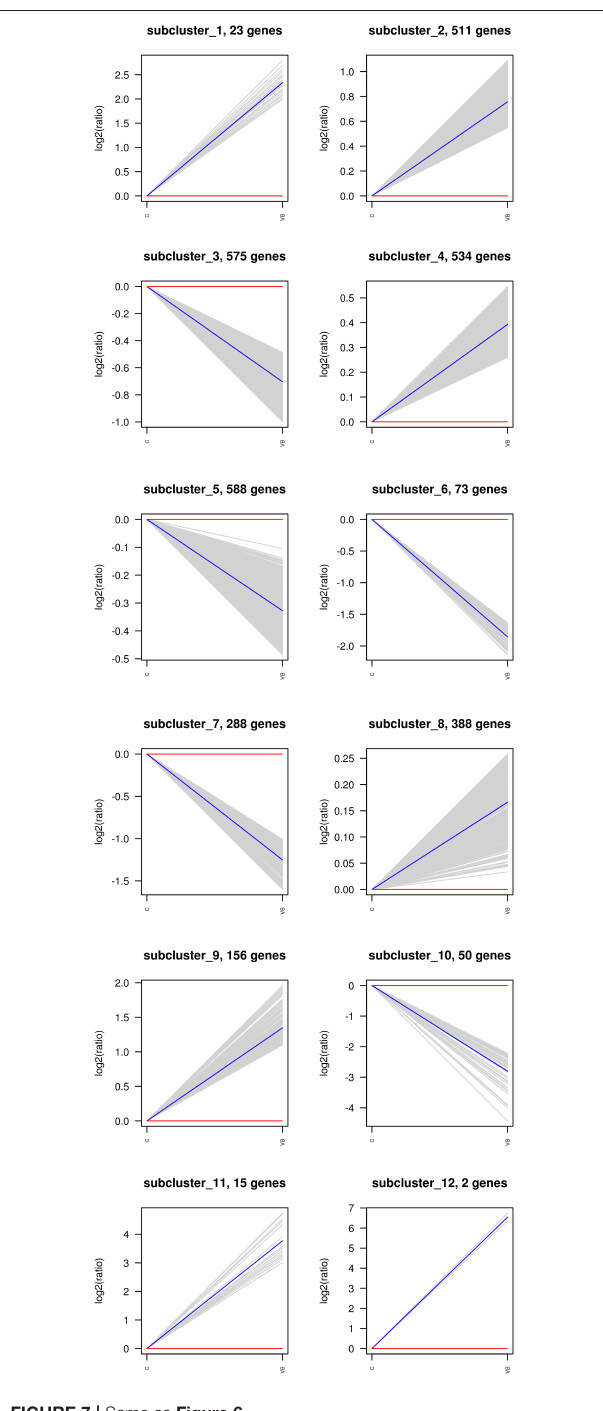
FIGURE 7 | Same as Figure 6